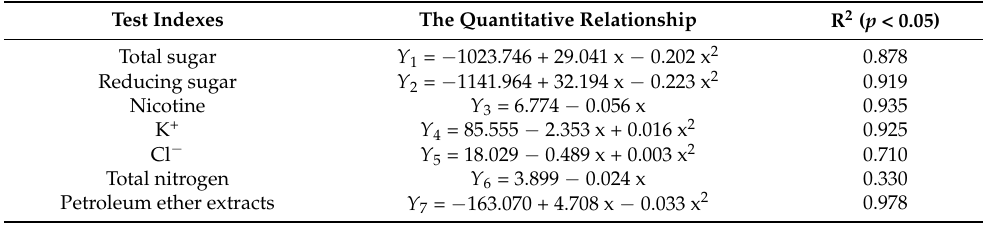
Table 7. The quantitative relationship between temperature during the stem-drying stage and inherent quality indexes of flue-cured tobacco after